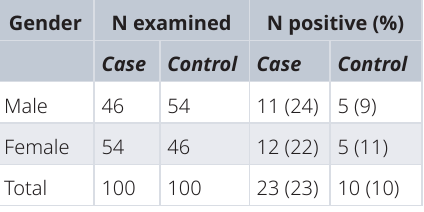
Table 1. Occurrence of gastrointestinal parasites among H. pylori patients and control individuals according to gender.